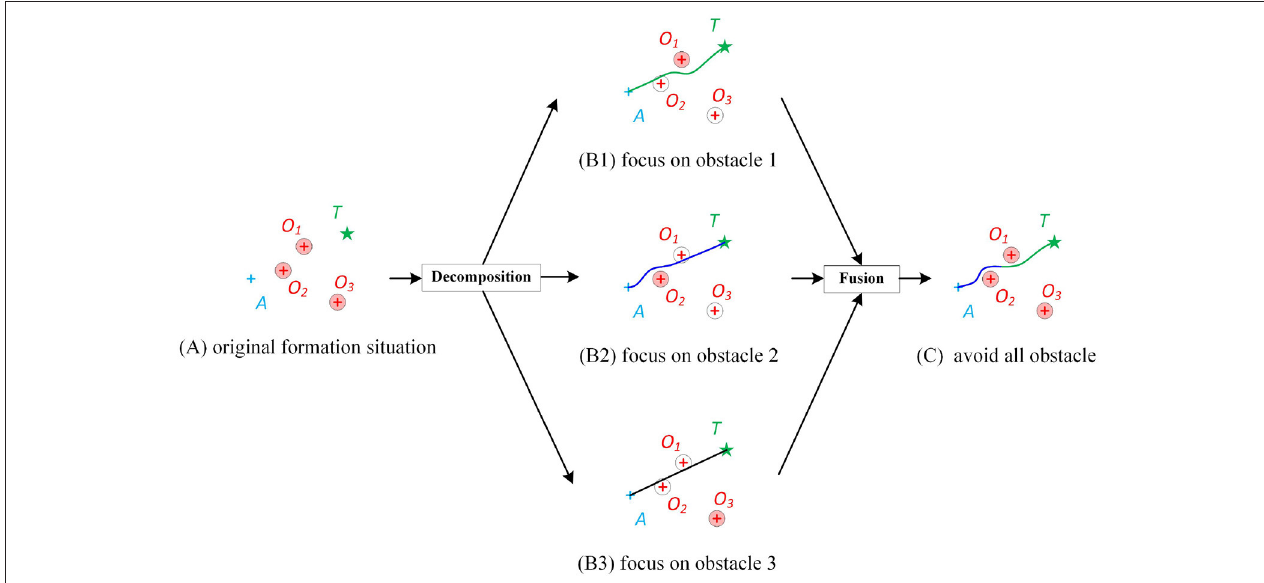
FIGURE 2 | Diagram of the proposed decomposition-fusion formation control framework. (A) A formation situation that the agent A is supposed to destinate target T but may be blocked by multiple obstacles O 1 , O 2 , and O 3 . The circle of the obstacle represents its collision zone. If the trajectory of the agent does not intersect with the collision zone, it means that the agent has no collision with the obstacle. (B) The decomposition of original formation by focusing obstacles one by one. The “focused” obstacle is colored by red while the “ignored” obstacles are colored white. (C) The trajectory from the fused controller.